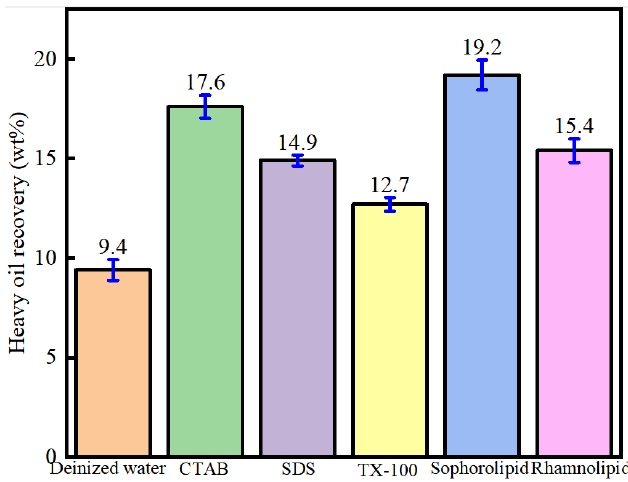
Figure 4. Heavy oil recovery using heavy-oil–carbonate-solid separation enhanced by five surfactants (500 ppm).